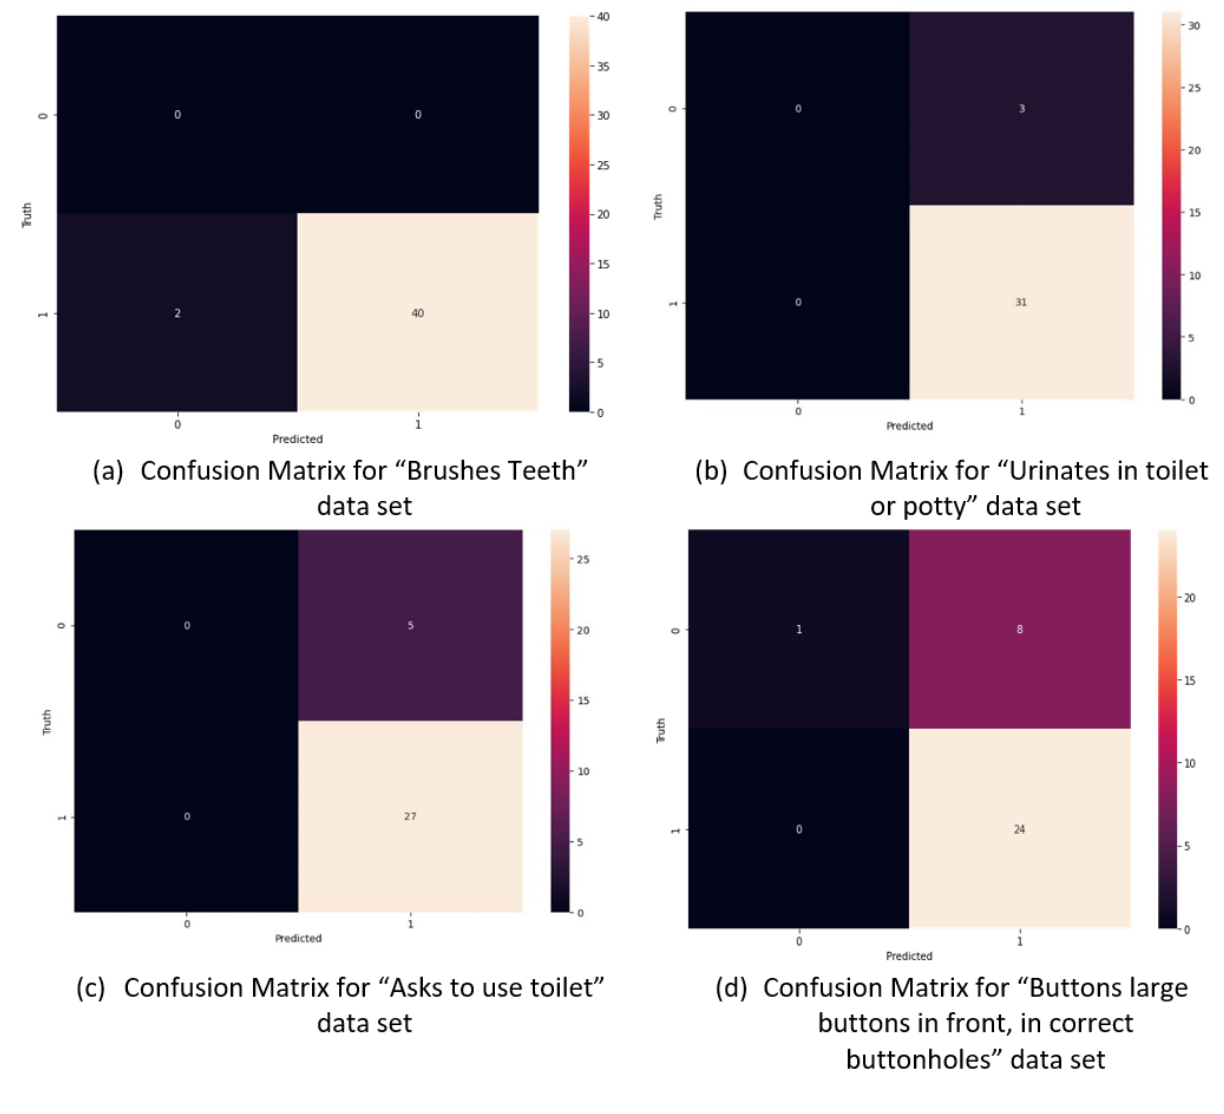
Figure 4. Confusion Matrix for all the